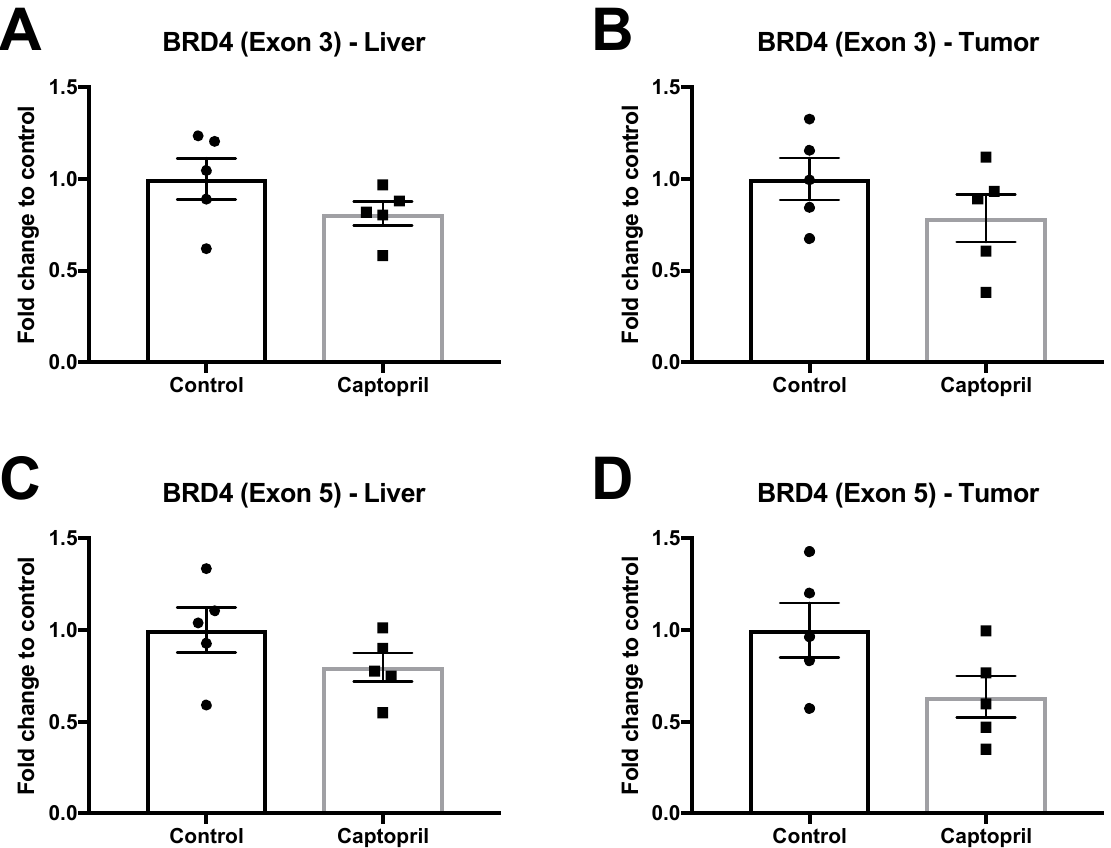
Figure 4. BRD4 expression (qRT-PCR) in liver and tumor tissues. Captopril treatment was not associated with any significant changes in BRD4 expression. ( A ) BRD4 Exon 3 liver ( p = 0.1843). ( B ) BRD4 Exon 3 tumor ( p = 0.2533). ( C ) BRD4 Exon 5 liver ( p = 0.1994). ( D ) BRD4 Exon 5 tumor ( p = 0.0865). Unpaired, two tailed t -test ( n = 5 mice).